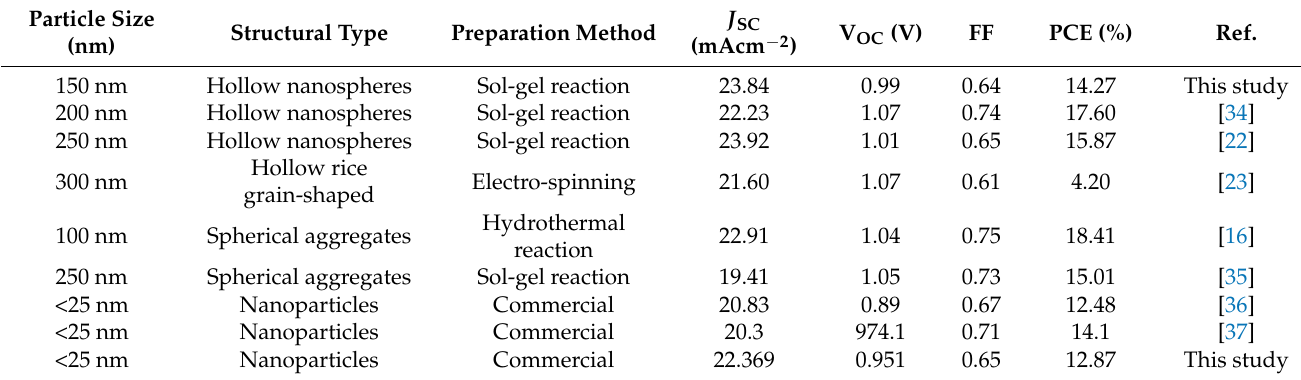
Table 3. Comparison of the photovoltaic parameters of recently PSCs based on hollow TiO 2 nanospheres and commercial TiO 2